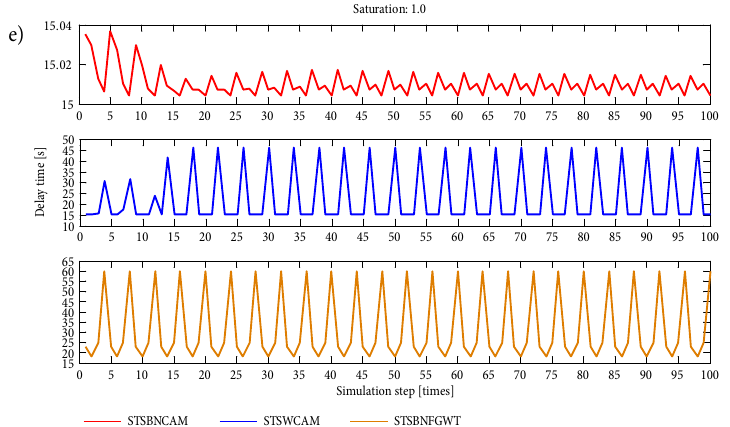
Fig. 5. The average delay time under different saturations: a – saturation = 0.1; b – saturation = 0.3; c – saturation = 0.5; d – saturation = 0.7; e – saturation = 1.0